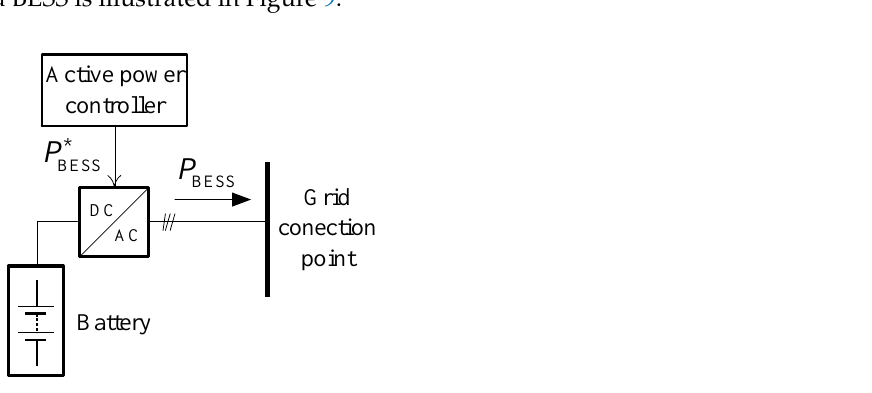
Figure 9. Basic components of the battery energy storage system (BESS).